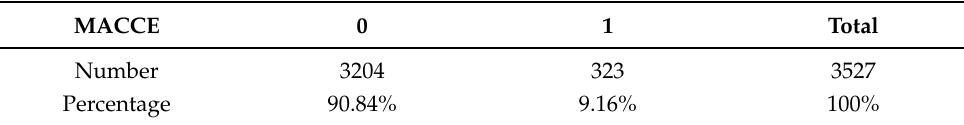
Table 2. The distribution of MACCE in